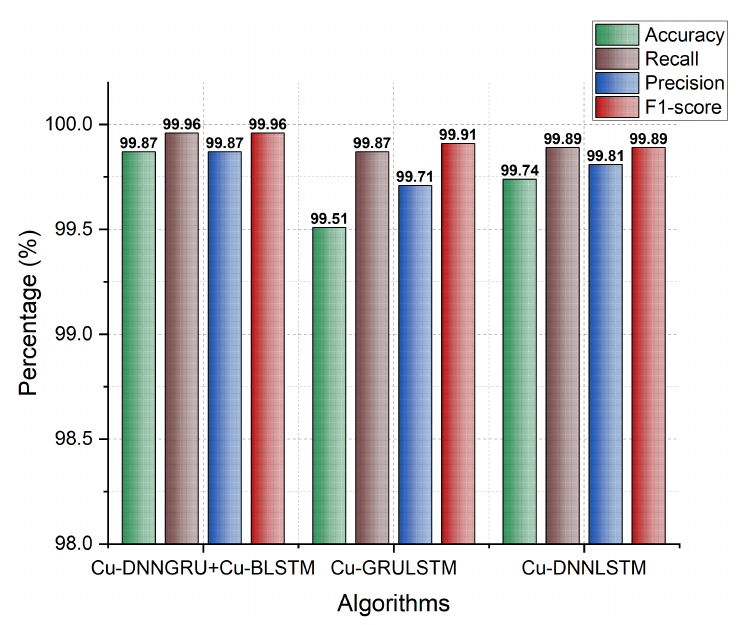
Figure 5. Accuracy, Recall, F1-score, and